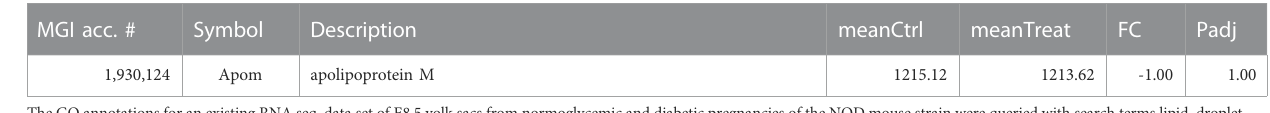
Frontiers in Cell and Developmental